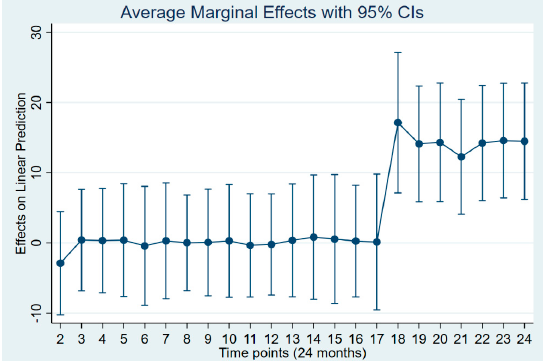
Figure A1. Average effects with 95% confidence intervals for the coefficients of placebo falsification tests, where the horizontal axis represents the time of placebo treatment, except for the 18th month which is the true treatment timing.